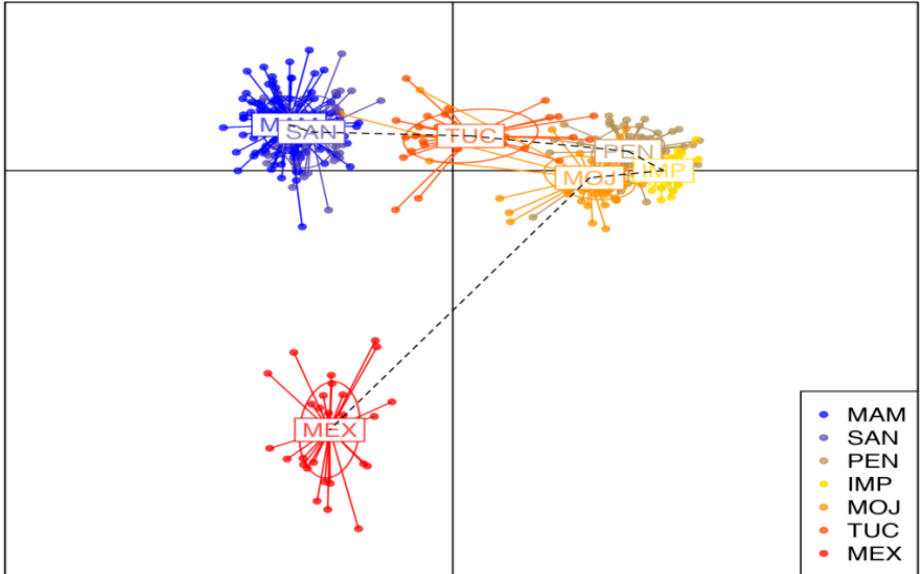
Figure 4. Scatterplot of Discriminant Analysis of Principle Components (DAPC) of three wild and four farmed populations of Arapaima gigas . Clusters are shown by different colors and inertia ellipses, while dots represent individuals. Wild population: MAM—Mamirau á ; SAN—Santar é m; MEX—Mexiana. Farmed population: TUC—Tucum ã ; PEN—Pentecostes; IMP—Imperatriz;